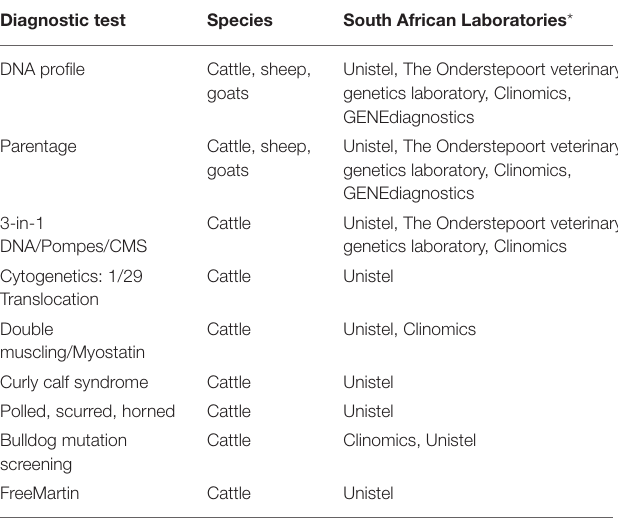
TABLE 2 | Diagnostic tests available for ruminants in South African